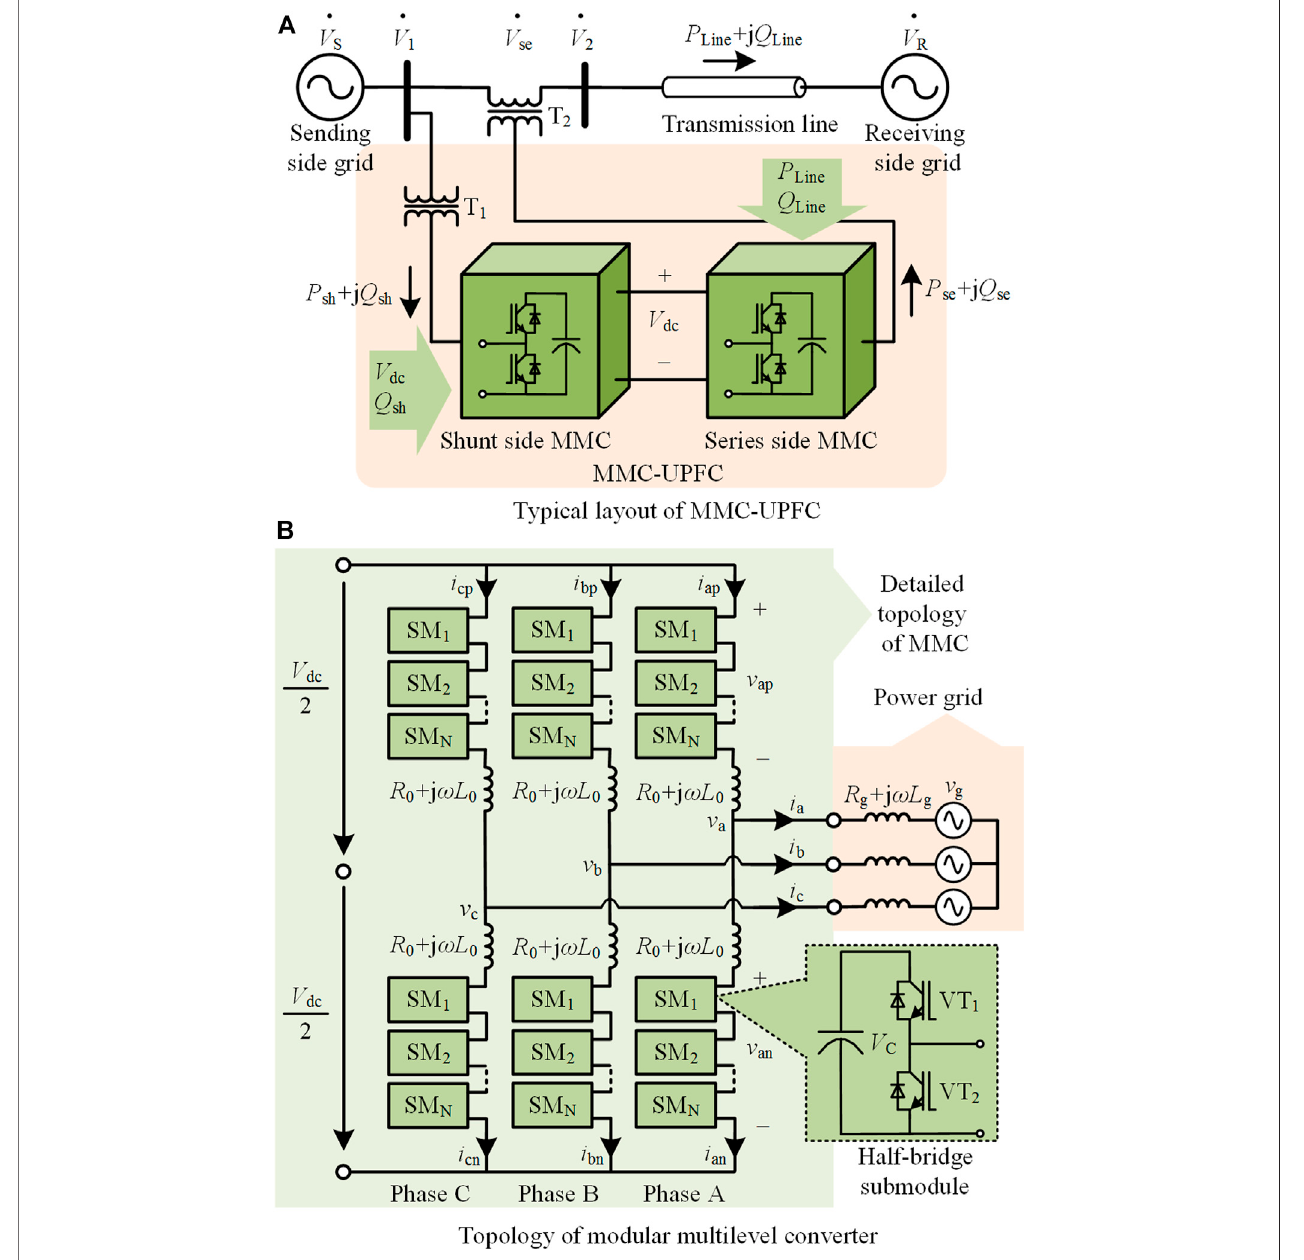
FIGURE 1 | Typical topology and application of MMC-UPFC in power grid.